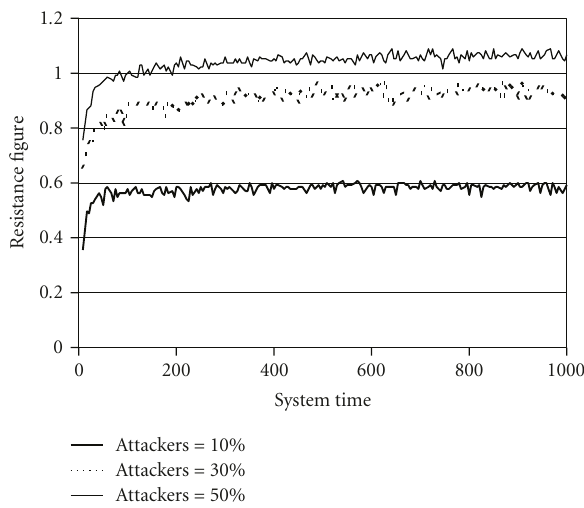
Figure 11: Resistance figure with various percentages of attackers in the integrated